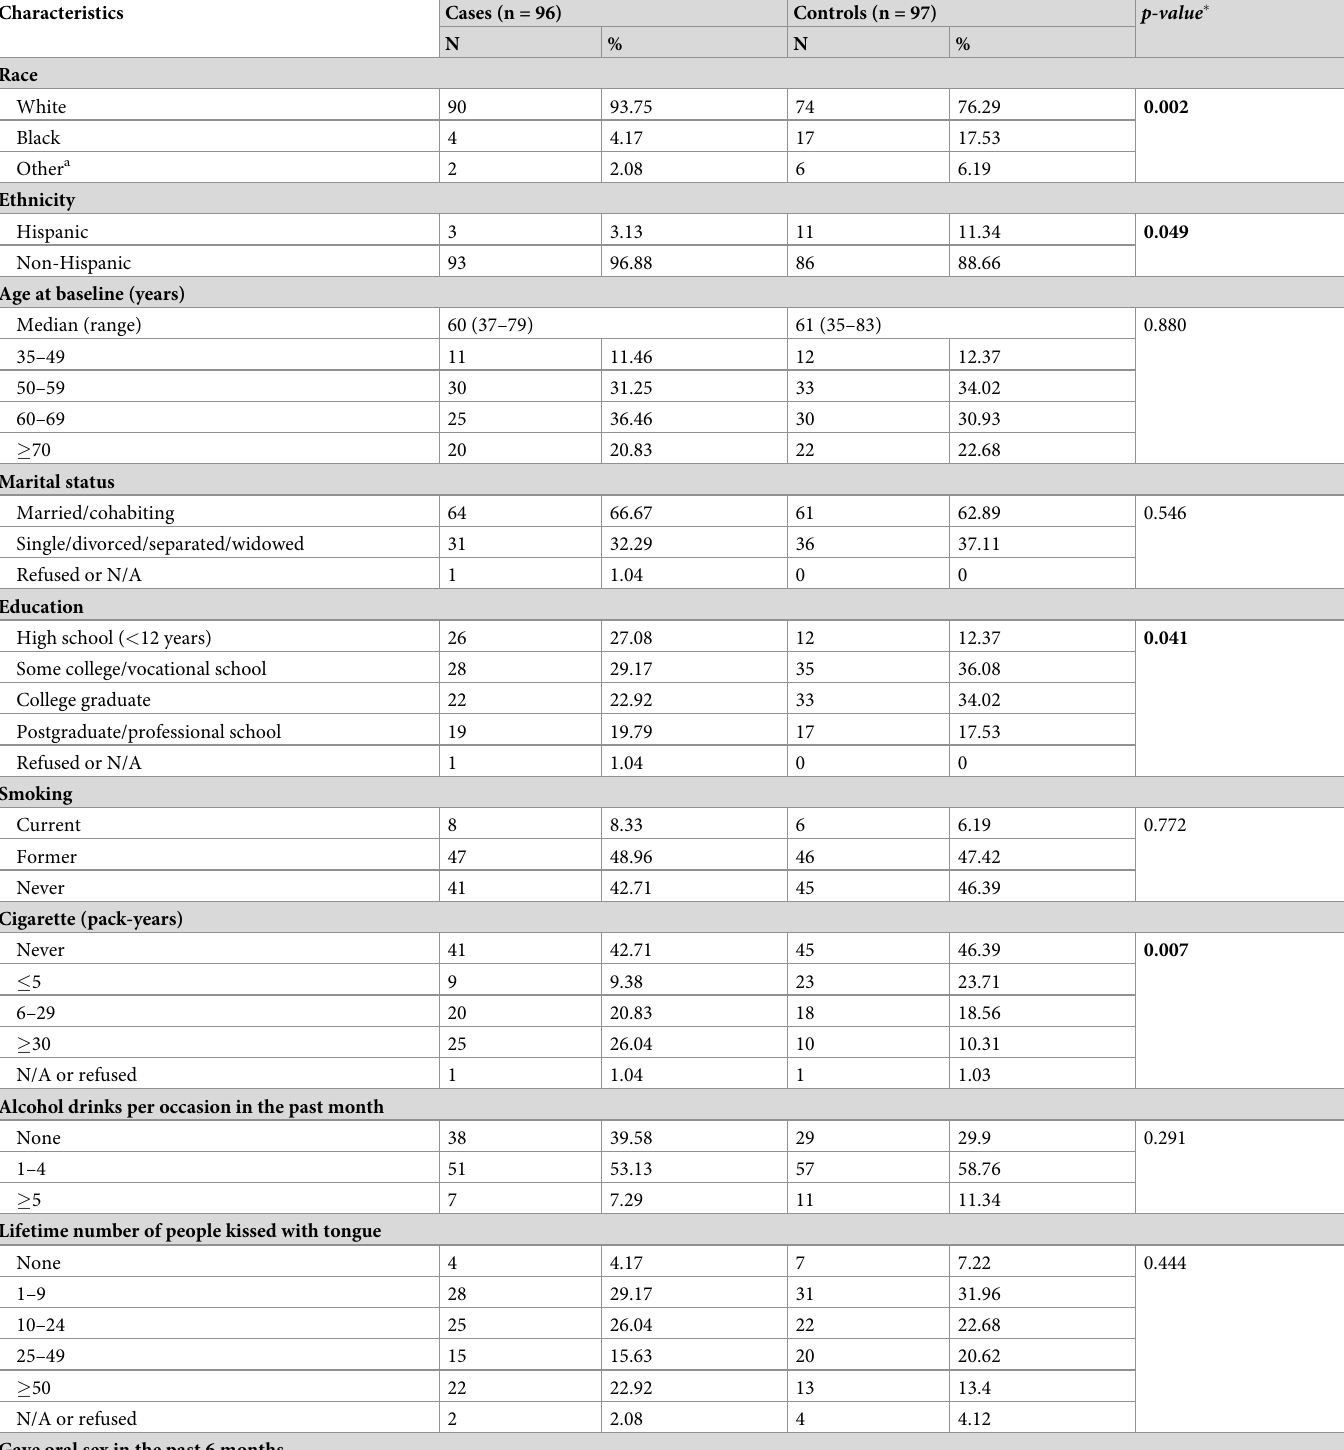
Table 1. Socio-demographic characteristics of OPSCC cases and disease-free controls.